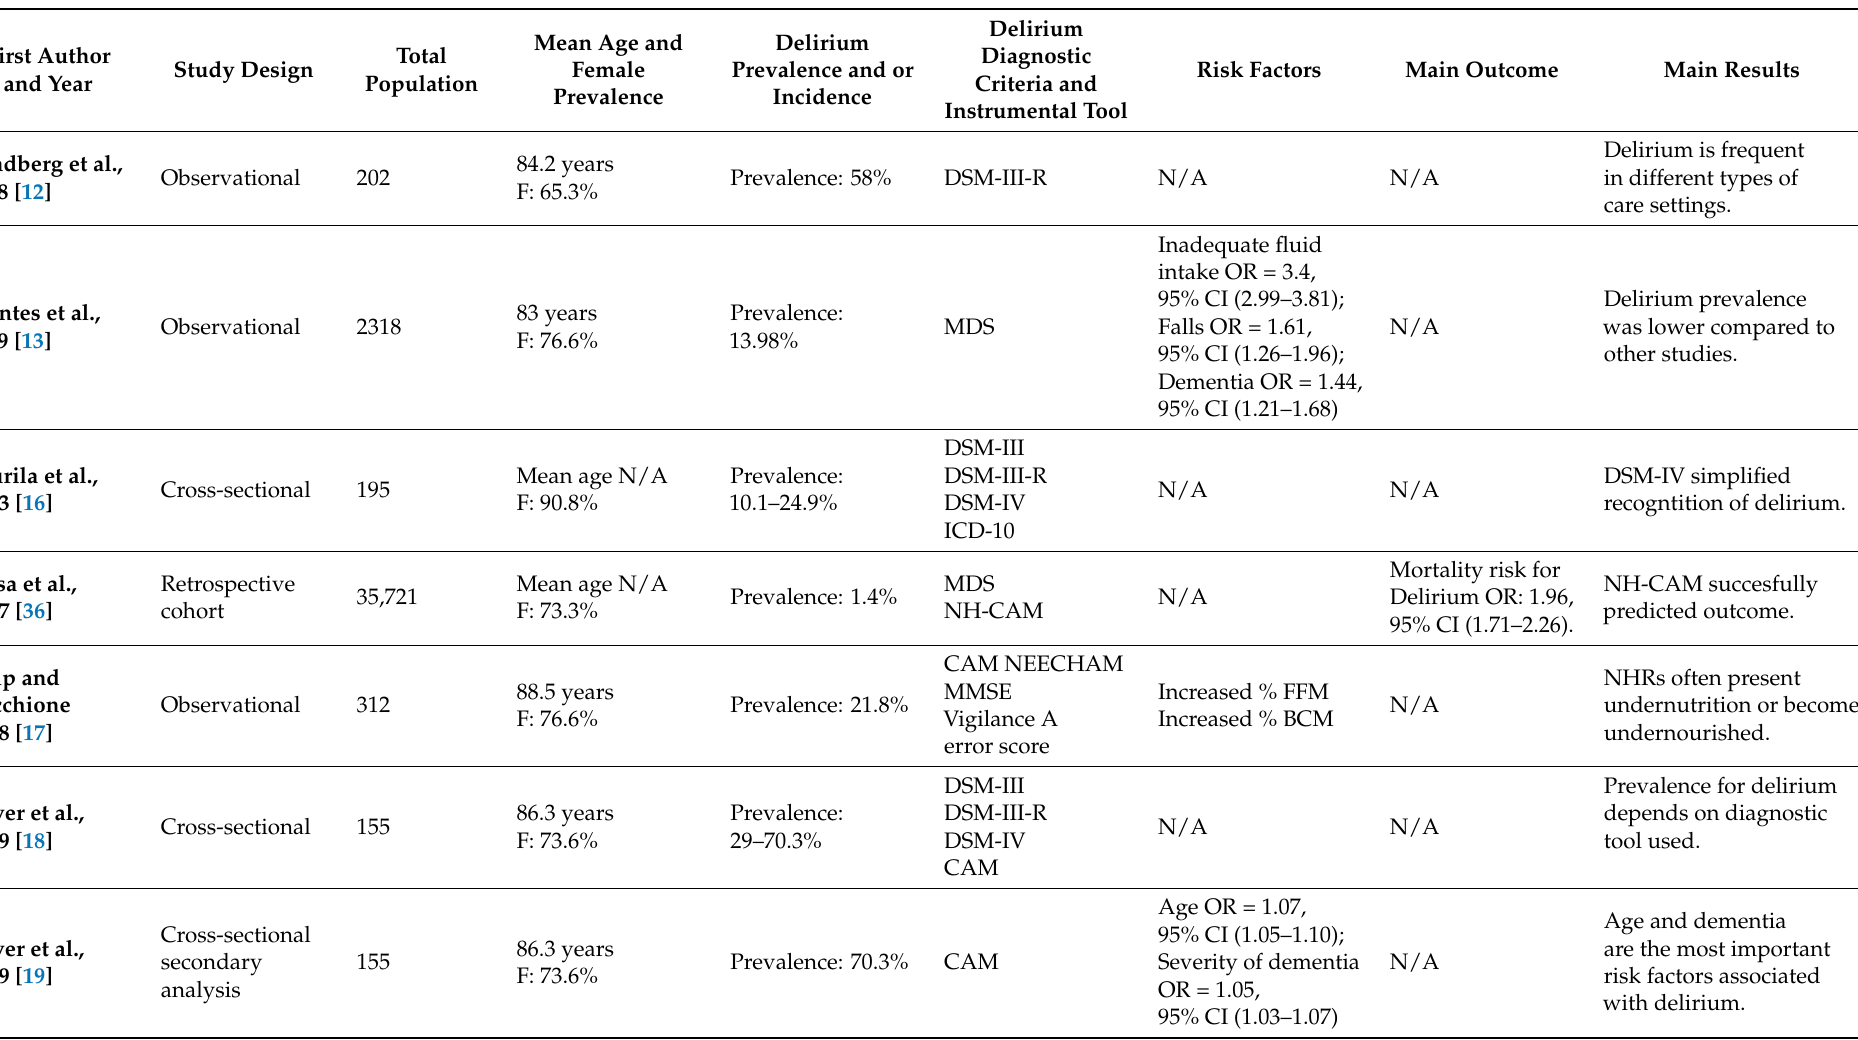
Table 1. Main characteristics of the studies focused on delirium in nursing home